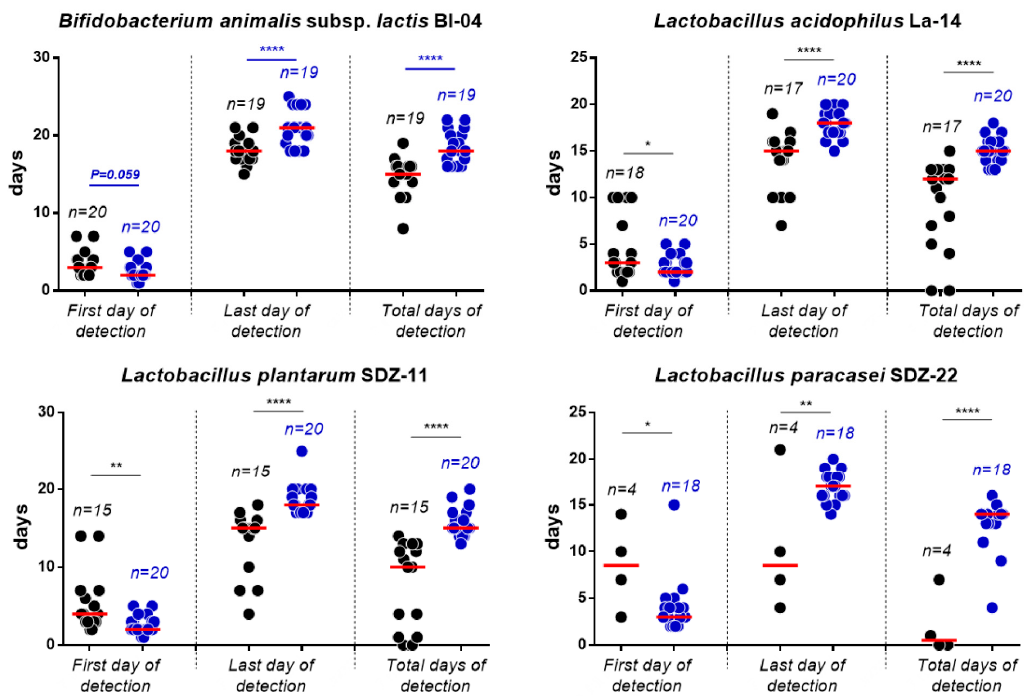
Figure 3. First, last, and total days of detection of probiotic strains in the fecal samples of volunteers receiving the 7 billion (black circles) and 70 billion (blue circles) formulations as demonstrated by qPCR analyses. Statistical analysis was performed according to a two-tailed unpaired t -test; *, p < 0.05; **, p < 0.01; ****, p <